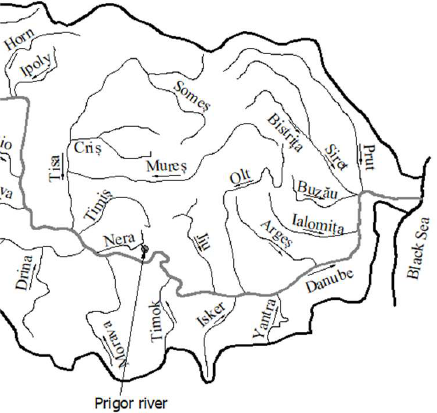
Figure 2. The location of Prigor River and Prigor hydrometric station.